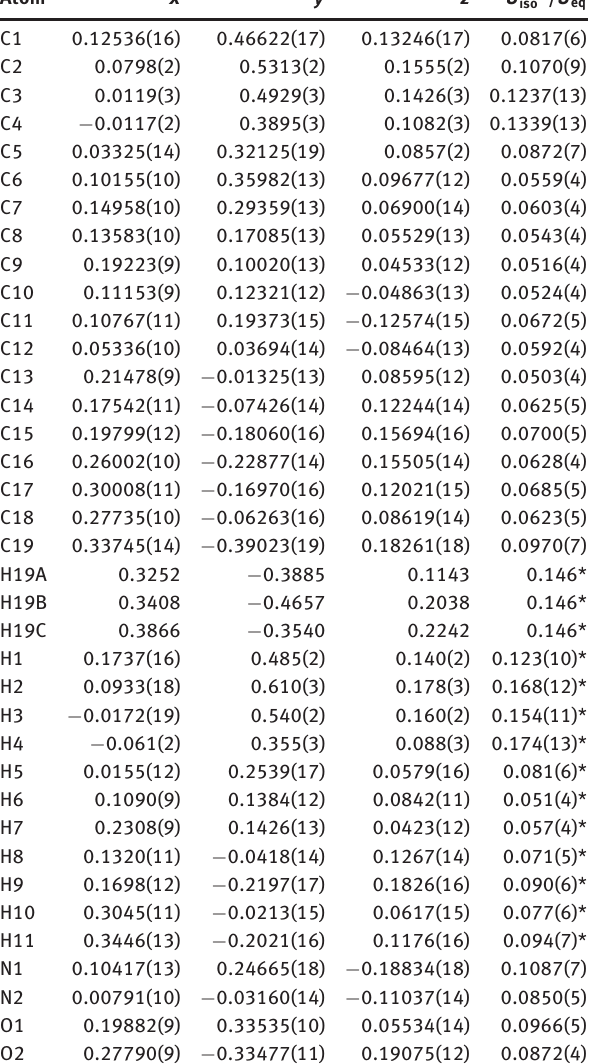
Table 2: Fractional atomic coordinates and isotropic or equivalent isotropic displacement parameters (Å 2